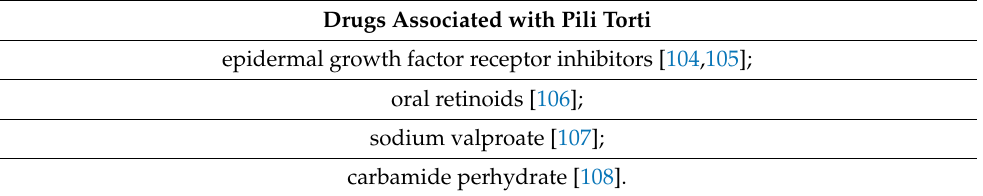
Table 4. Drugs related to pili torti formation.